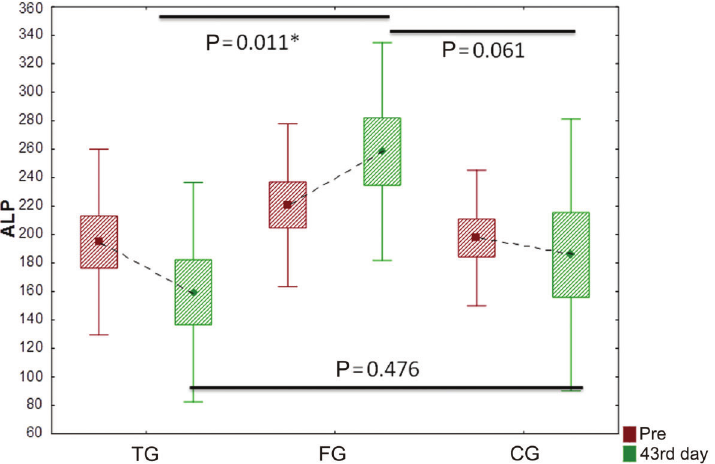
Figure 2. Comparison of alkaline phosphatase (ALP) among groups. Data are reported as averages, standard deviation and maximum and minimum errors. TG: transcutaneous electrical nerve stimulation (TENS) group; FG: functional electrical stimulation (FES) group; CG: control group. Student ’ s t -test was used for statistical analysis (*P o 0.05).